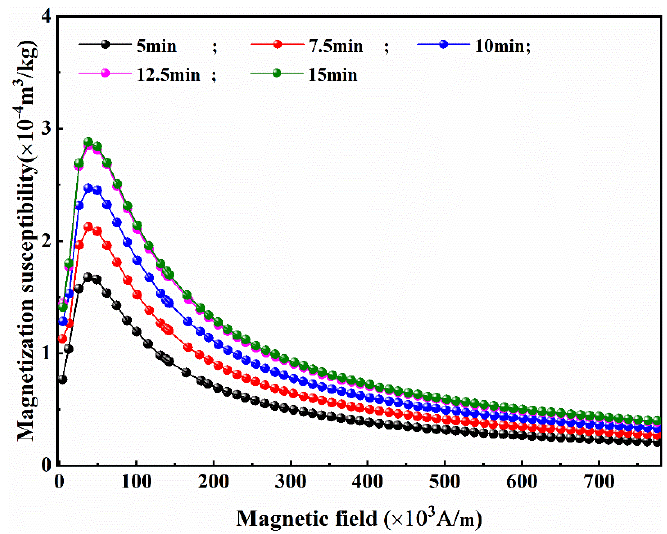
Figure 8. Magnetic susceptibility curves of roasted products.